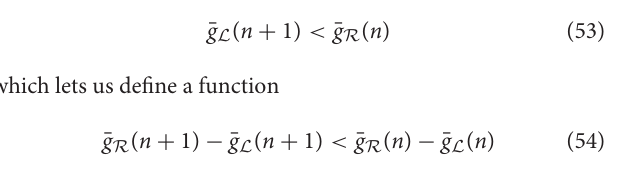
the stable fixed points given implicitly by d ⋆ 43). At the right bifurcation border ¯ g R ( n ) we have 1 t = T s ,